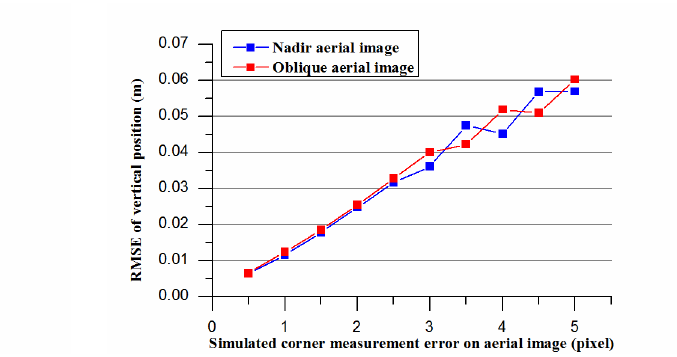
Figure 6. Horizontal error ( Left ) and vertical error ( Right ) of nadir image and oblique image.